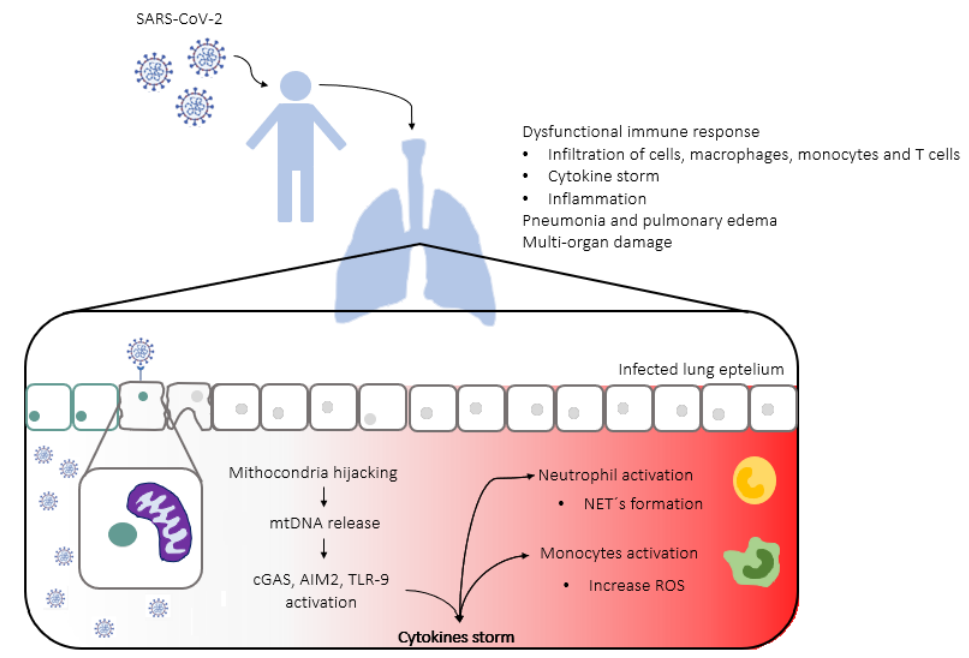
Figure 1. Severe acute respiratory syndrome coronavirus 2 (SARS-CoV-2) lung pathogenesis. SARS-CoV-2 infected cells express the angiotensin-converting enzyme 2 (ACE2) receptor and TMPRSS2, seen in cells of the respiratory tract, among other tissues. The SARS-CoV-2 virus during the replication process